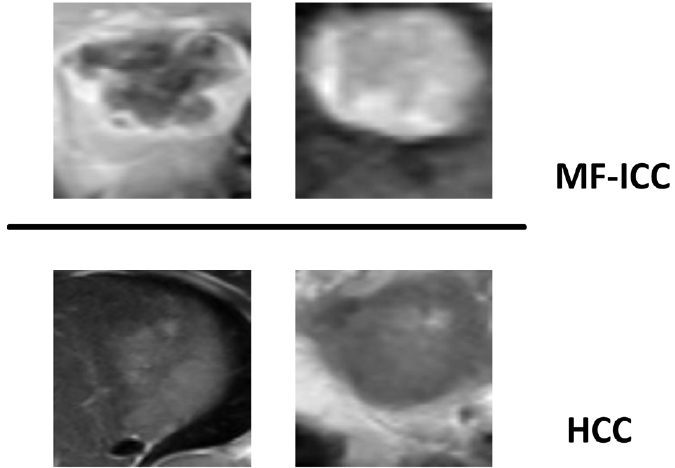
Figure 9. MF-ICC/HCC lesion images incorrectly classified by the SFFNet model in the validation set (top: MF-ICC image was misclassified as HCC; bottom: HCC image was misclassified as MF-ICC). Table 3. Comparison of different classification